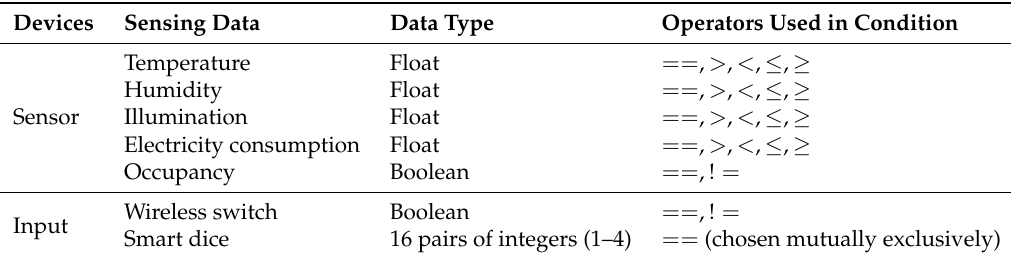
Table 2. Data type and operators for IoT devices used in the